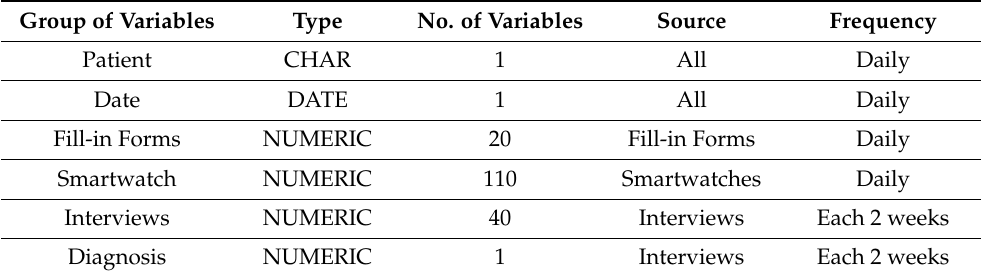
Table 1. Data structure of all the